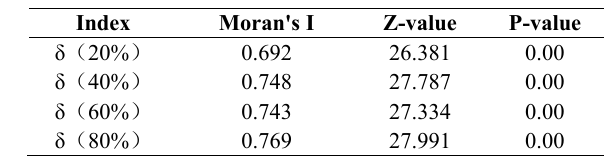
Table 5 . Moran's I value of mismatch degree of material supply and demand under different simulation degrees